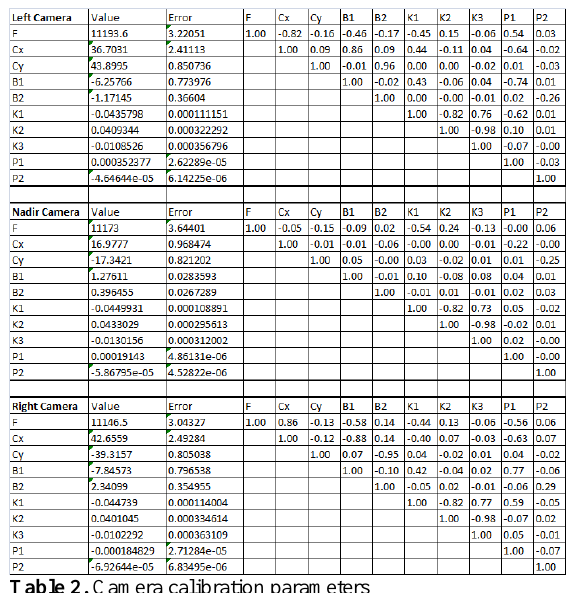
Table 2. Camera calibration parameters